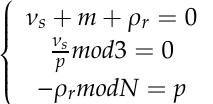
Table 2. The formulae for frequencies indicating particular faults [1].